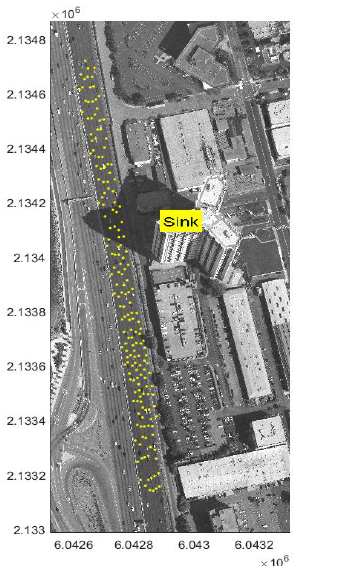
Figure 1. The location of vehicle sensors and sink